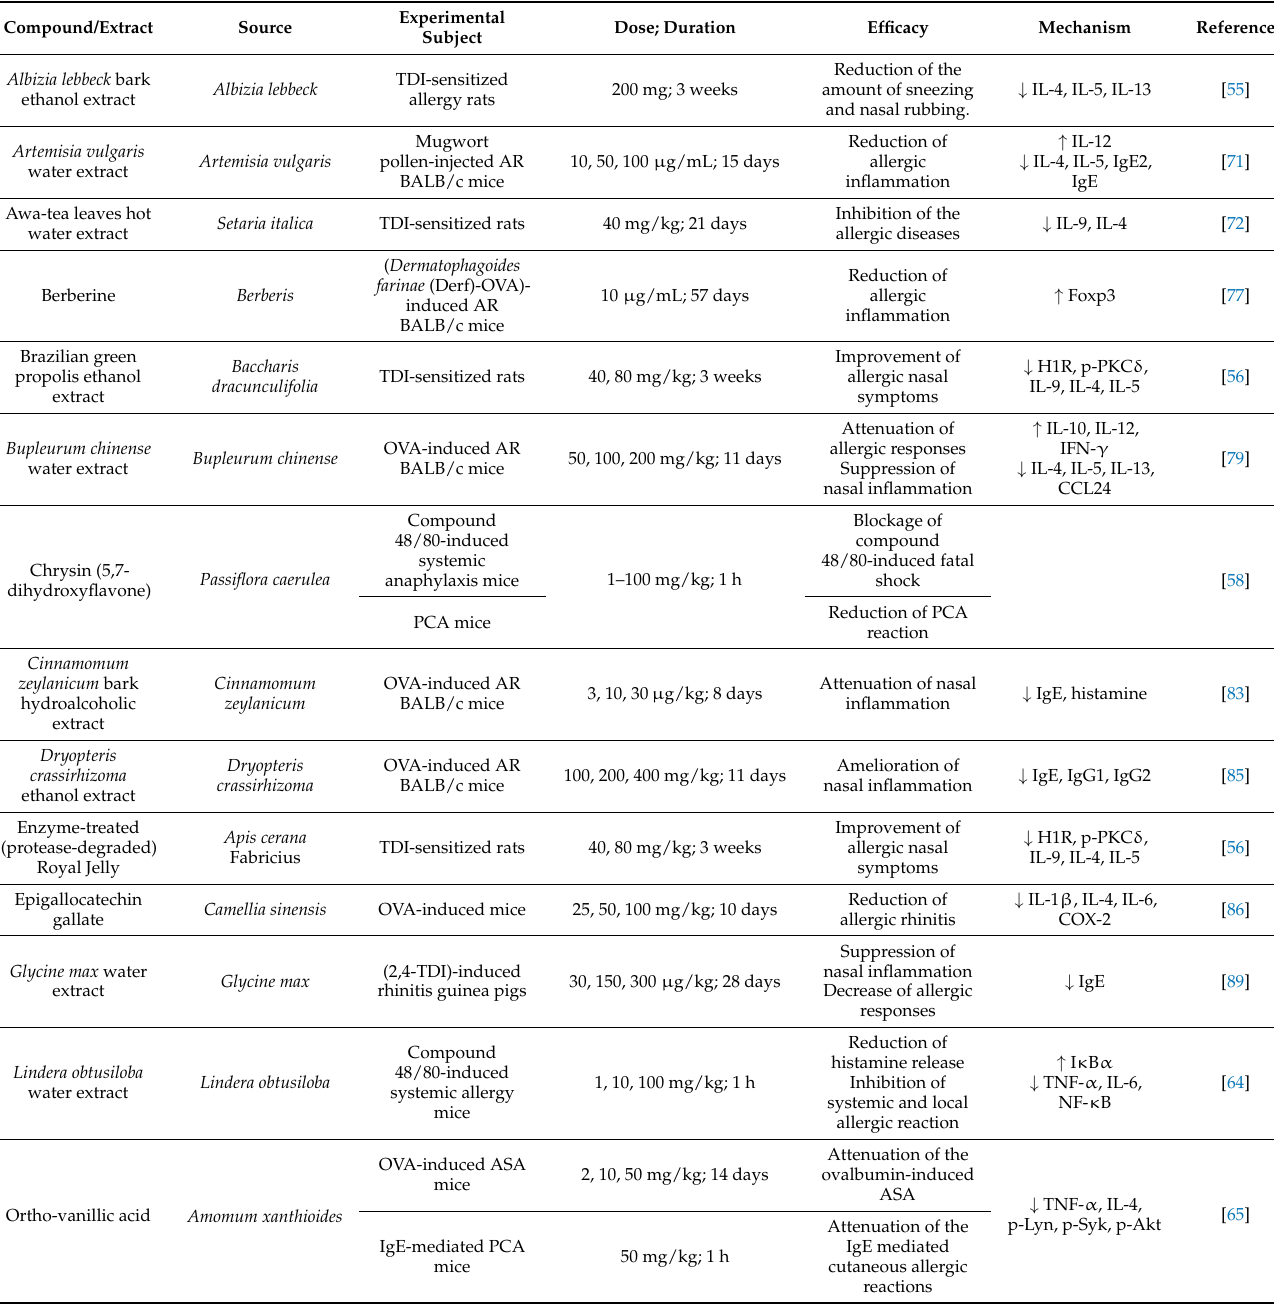
Table 2. In vivo studies—plant-originated natural